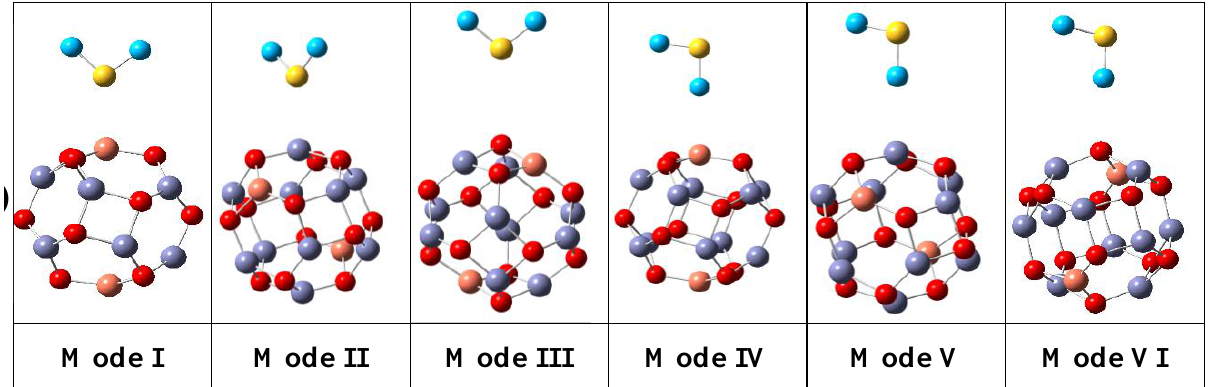
Figure 4. The non-optimized adsorbate-substrate adsorption modes of H 2 S/Cu 2 Zn 10 O 12 and SO 2 /Cu 2 Zn 10 O 12 complexes. The cyan atom represents H or O atoms.